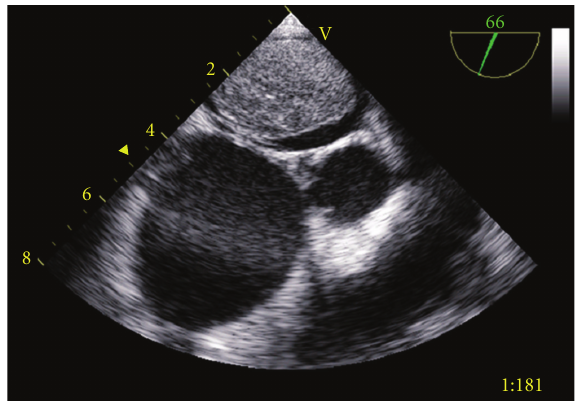
Figure 1: Ultrasound of the heart showing a round left intra-atrial tumour mass, compromising almost the whole left